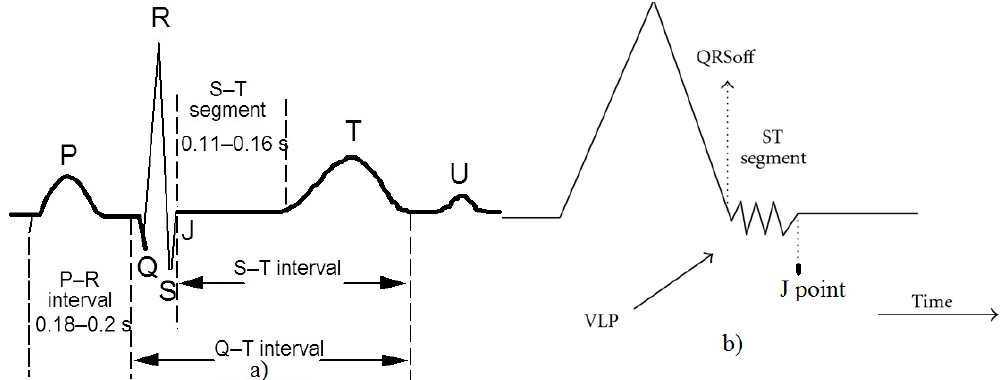
Figure 1. ( a ) Characteristic shape of an ECG heartbeat; and ( b ) VLP onset